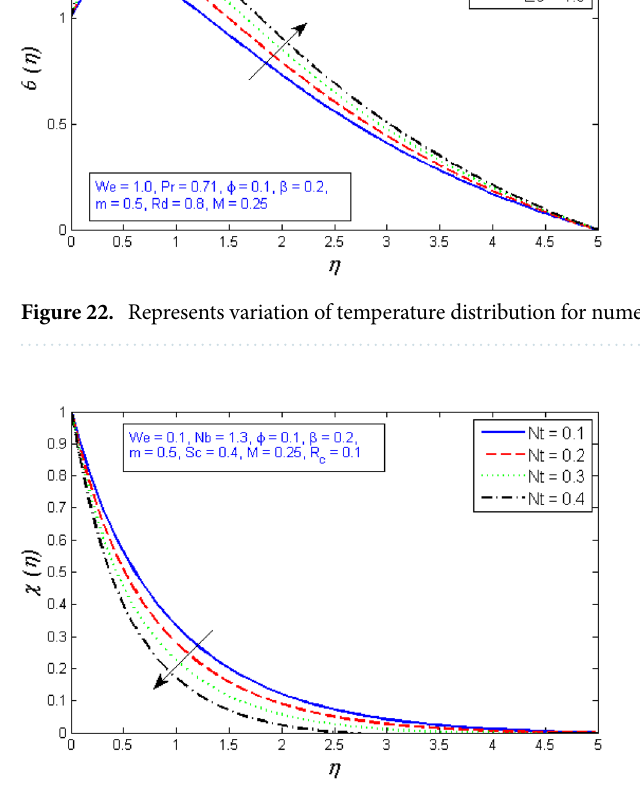
Figure 23. Represents variation of concentration profile for numerous number of thermophrosisparameter Nt .